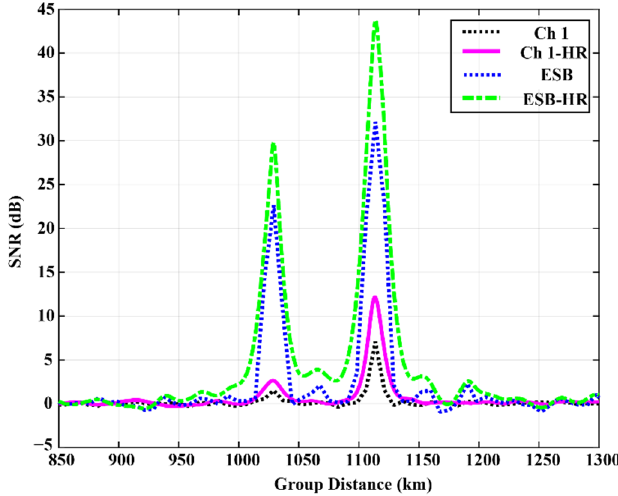
Figure 11. Comparison of SNR at 7.6 MHz under different conditions after subtracting back- Comparison of SNR at 7.6 MHz under different conditions after subtracting ground noise. background